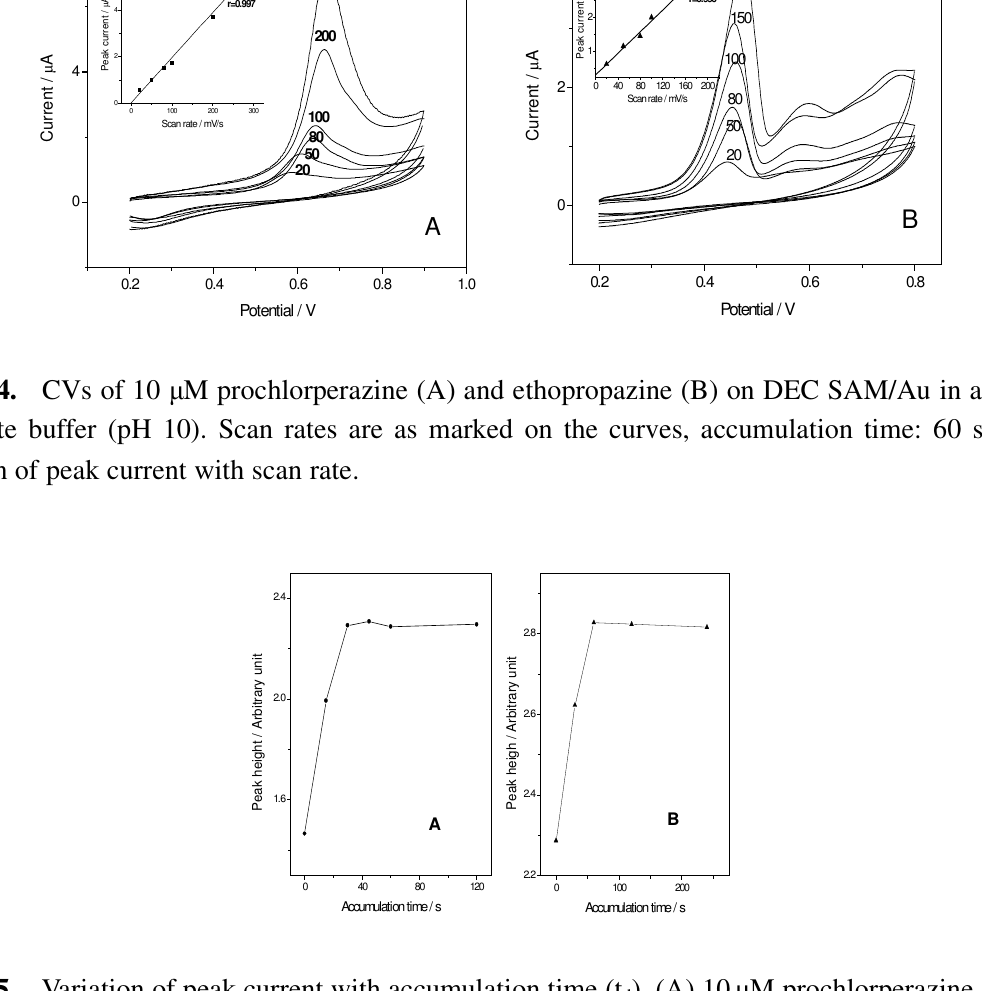
Figure 5. Variation of peak current with accumulation time (t d ). (A) 10 (cid:1) M prochlorperazine, E d : -0.4 V; (B) 10 (cid:1) M ethopropazine, E : 0 V. Other conditions as in Figure d